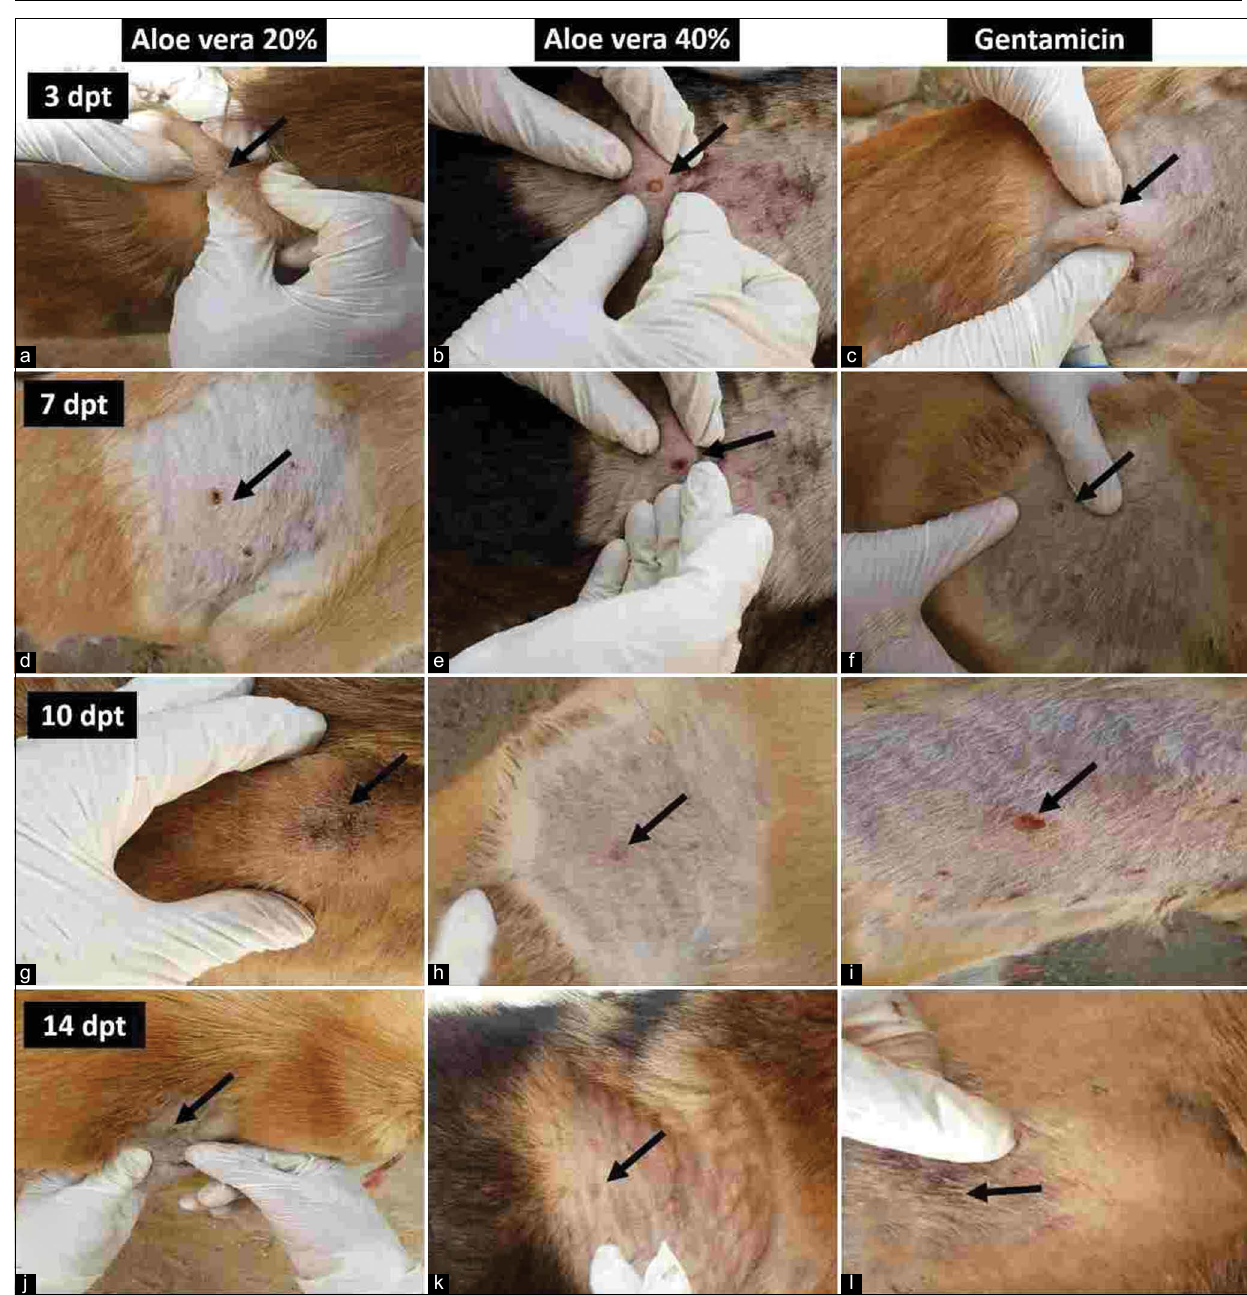
Figure-3: Treated group. On 3 rd days post-treatment (DPT), (a) Skin treated with Aloe vera ointment 20% showed erythema, pus filled pustules. (b) Skin treated with A. vera ointment 40% showed erythema, pruritis, and presence of pus. (c) Skin treated with gentamicin 0.1% showed erythema and whitish pus content. On 7 th DPT, (d) skin treated with A. vera ointment 20% showed erythema with moderate pus content. (e) Skin treated with A. vera ointment 40% showed erythema with less pus content. (f) Skin treated with gentamicin ointment 0.1% showed erythema and moderate pus content. On 10 th DPT, (g) skin treated with A. vera ointment 20% showed small amounts of pus. (h) Skin treated with A. vera ointment 40% showed epidermal collarette with absence of pus. (i) Skin treated with gentamicin ointment 0.1% showed little pus. On 14 th DPT, (j) skin treated with A. vera ointment 20% showed epidermal collarette with absence of pus. (k) Skin treated with A. vera ointment 40% showed complete healing. (l) Skin treated with gentamicin ointment 0.1% showed epidermal collarette. Lesions are indicated by